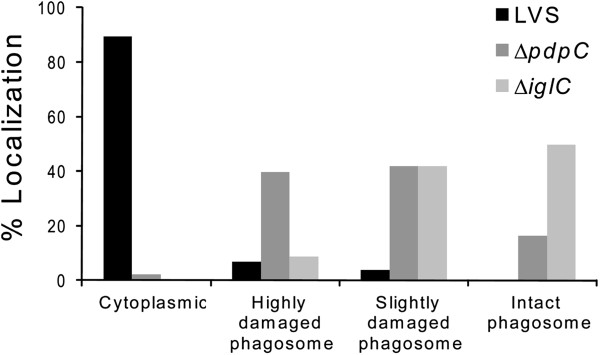
Subcellular colocalization in J774 cells of F. tularensis bacteria. J774 cells were infected for 2 h with F. tularensis strains and, after washing, incubated for 6 h. Bacteria were examined using transmission electron microscopy (TEM) and categorized into one of four categories depending on the preservation of the phagosomal membrane. At least 100 bacteria per sample were scored. Results from a representative experiment are shown.